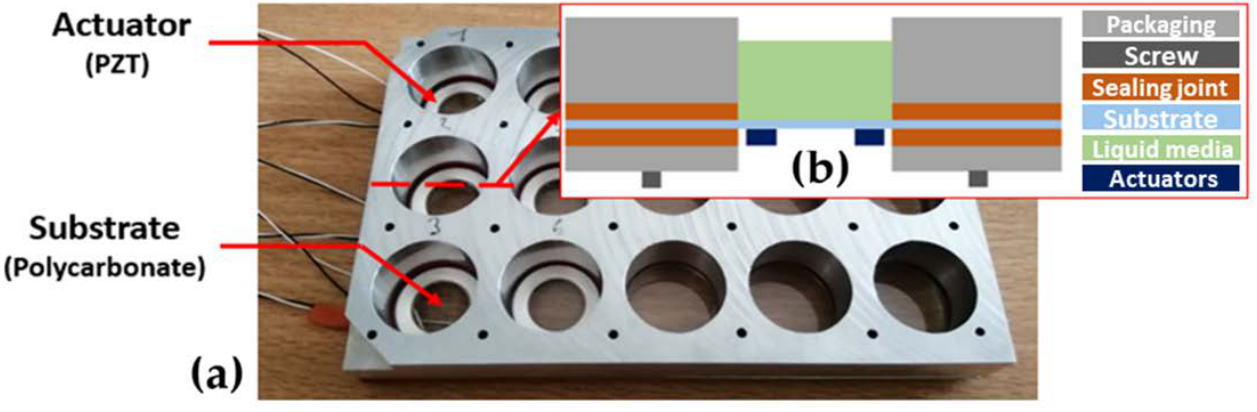
Figure 3. ( a ) Photography of the packaged membranes ready to be tested, and ( b ) cross-section diagram of a vibrating membrane.